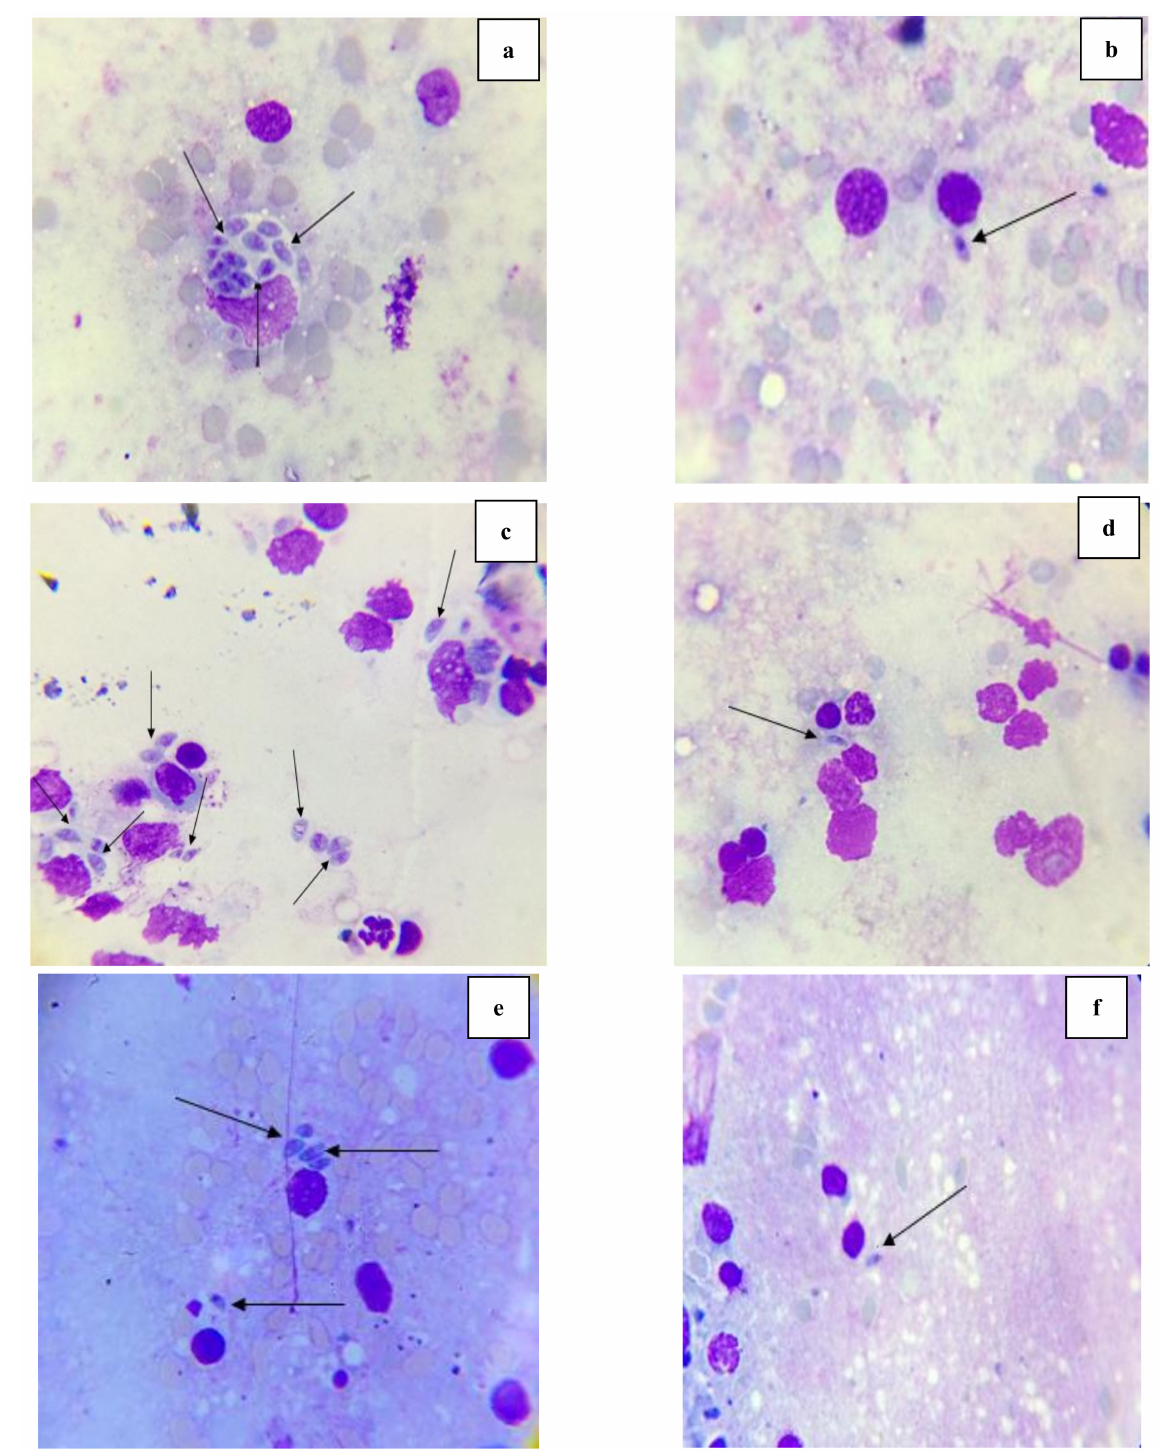
Figure 7. Giemsa-stained impression smears of liver, spleen and brain showing Toxoplasma tachyzoites in infected untreated control and infected treated mice. ( a ): T. gondii tachyzoites in infected untreated control liver (Giemsa stain × 1000). ( b ): T. gondii tachyzoites in infected treated liver (Giemsa stain × 1000). ( c ): T. gondii tachyzoites in infected untreated control spleen (Giemsa stain × 1000). ( d ): T. gondii tachyzoites in infected treated spleen (Giemsa stain × 1000). ( e ): T. gondii tachyzoites in infected untreated control brain (Giemsa stain × 1000). ( f ): T. gondii tachyzoites in infected treated brain (Giemsa stain ×